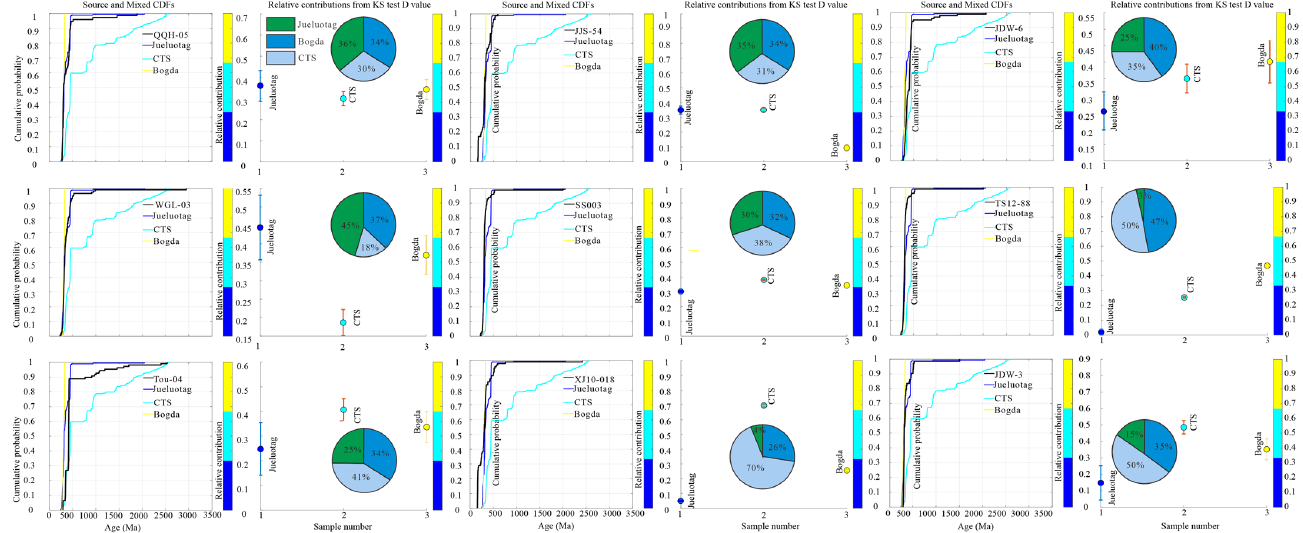
Figure 15. Decomposition model quantifying the U-Pb age distribution of detrital zircons from different source areas using DZ mixed modeling [8]; J2-Dzmix.